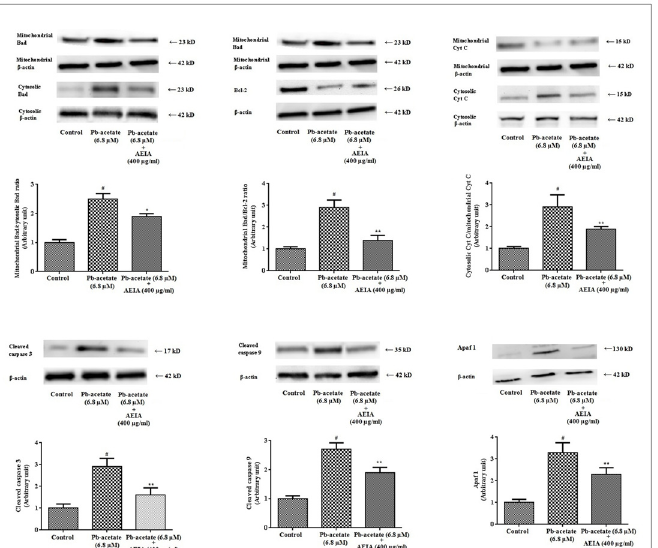
Fig 3. Respective western blot analysis of Bcl-2, Bad, cleaved caspase 9 and 3, Cyt C, and Apaf 1 in the absence (Pb-acetate) and existence of AEIA (Pb-acetate + AEIA) in mouse hepatocytes. The relative band intensities were measured and the normal control band was given an arbitrary value of 1. β - actin was used as a loading protein. Values were expressed as mean ± SE (n = 3). # Values differed (p < 0.01) significantly from normal control. * Values differed (p < 0.05) significantly from Pb-acetate. ** Values differed (p < 0.01) significantly from Pb-acetate control.